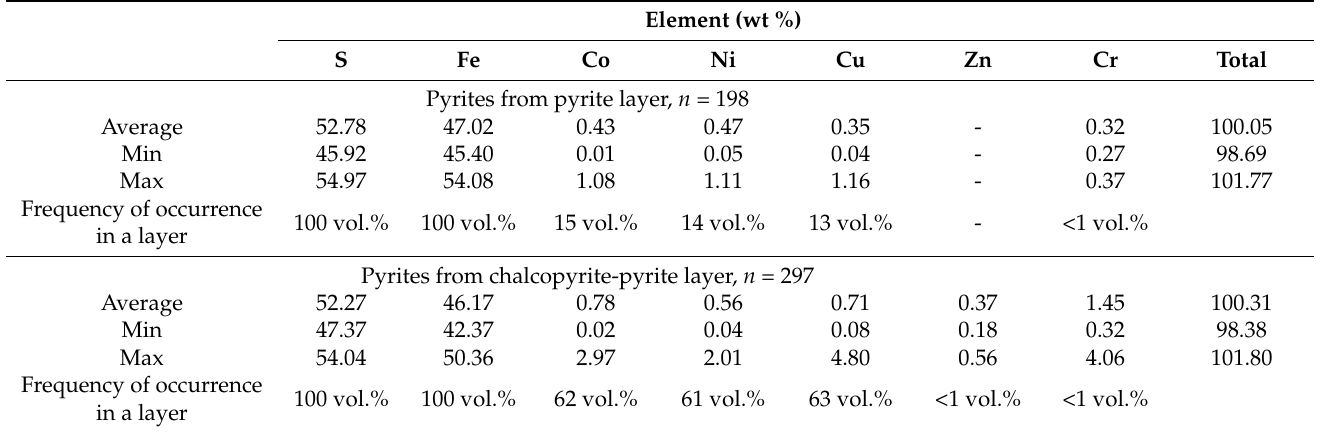
Table 3. Variations in the pyrite compositions from st. 242 (wt %).